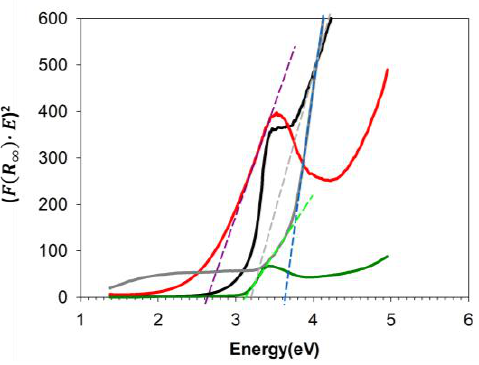
Figure 7. Tauc’s plot was used to determine the investigated composites’ optical bandgap.